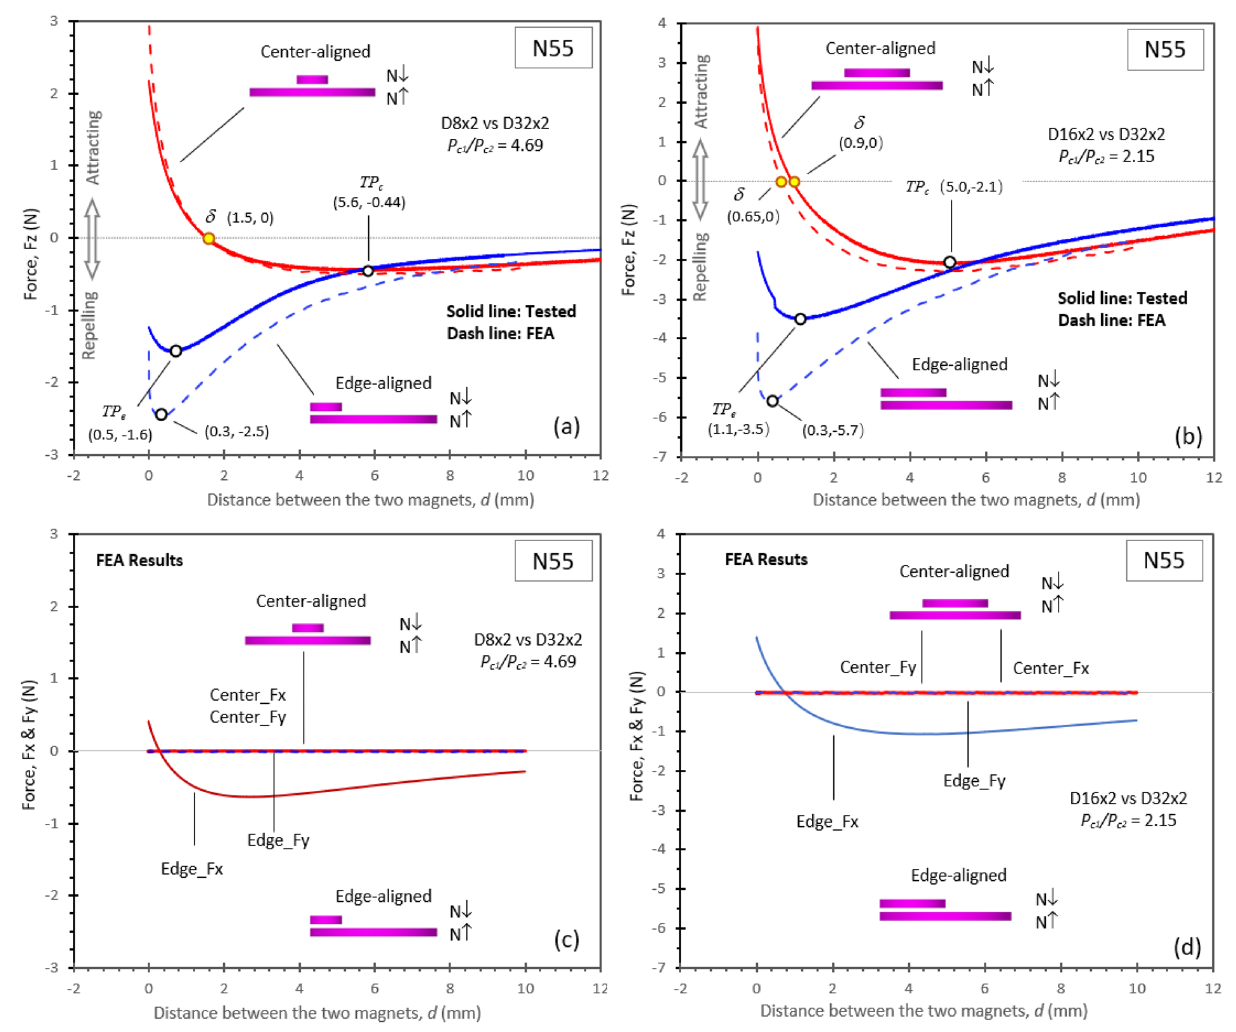
Figure 3. The tested force and FEA simulated force F z vs. distance between two sets of N55 like poles. For the center-aligned like poles, the tested and simulated results are almost identical, with the same turning points TP and the zero force points δ. All these four curves of force vs. distance shown in Fig. 3( a ) and ( b ) display an undisputable transition from a negative force, or a repulsion, to a positive force, or an attraction. This is a remarkable verification of the fact that the attraction can occur to these like magnetic poles. For the edge- aligned like poles, although the tested and simulated forces F z shown in Fig. 3( a ) and ( b ) do not completely coincide, the shapes of the curves are similar. Both the tested and simulated curves show the turning point TP at similar distances. It is believed that the difference between the tested F z and the FEA simulated F z for the edge- aligned pairs is due to the complication or the influence from the force in the x-axis direction, F x . As shown in Fig. 3( c ) and ( d ), the F x is non-neglectable, and it produces a torque to affect the F z . The fact of the turning point TP is unmistakable, and the simulated curves show a larger repelling force. The FEA successfully verified the attractive condition for unequally sized like